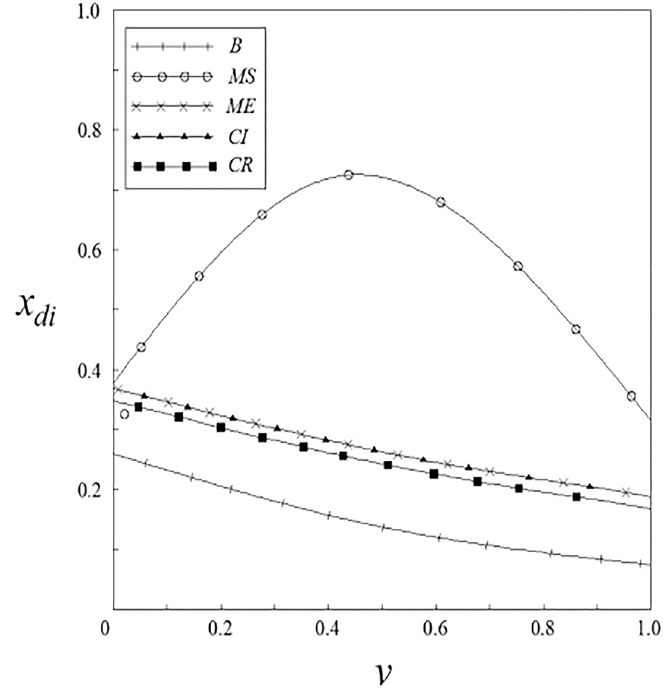
Fig 3. The relationship between x di and ν .